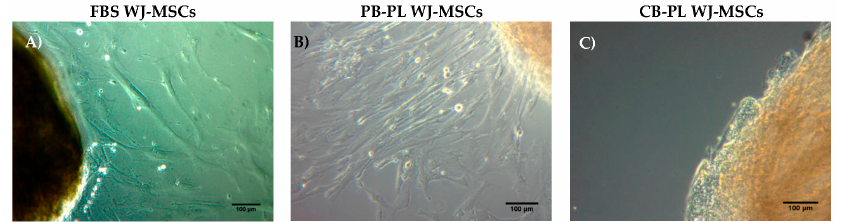
Figure 1. Isolation of MSCs from Wharton Jelly tissue using growth media supplemented with 15% FBS, 10% PB-PL and 10% CB-PL. ( A ) FBS expanded WJ-MSCs after 6 days of culture under standard conditions. ( B ) PB-PL expanded WJ-MSCs after 7 days of culture. ( C ) CB-PL growth medium failed to expand the WJ-MSCs even after 20 days of culture under standard conditions. Original magnification 10 × , scale bars 100 µ m. Bioengineering 2018 , 5 , x FOR PEER REVIEW